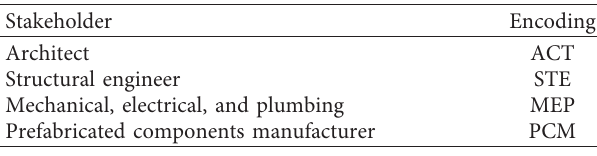
Table 5: Encoding of stakeholder.